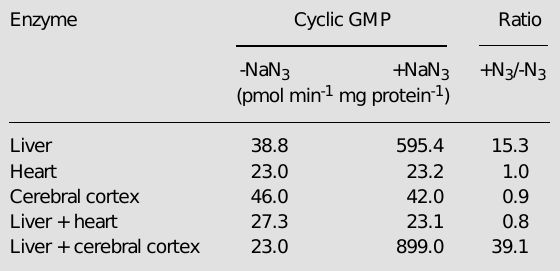
Table 1 - Effects of NaN 3 on soluble guanylyl cyclase from rat liver, heart and cerebral cortex. From Ref. 15, with